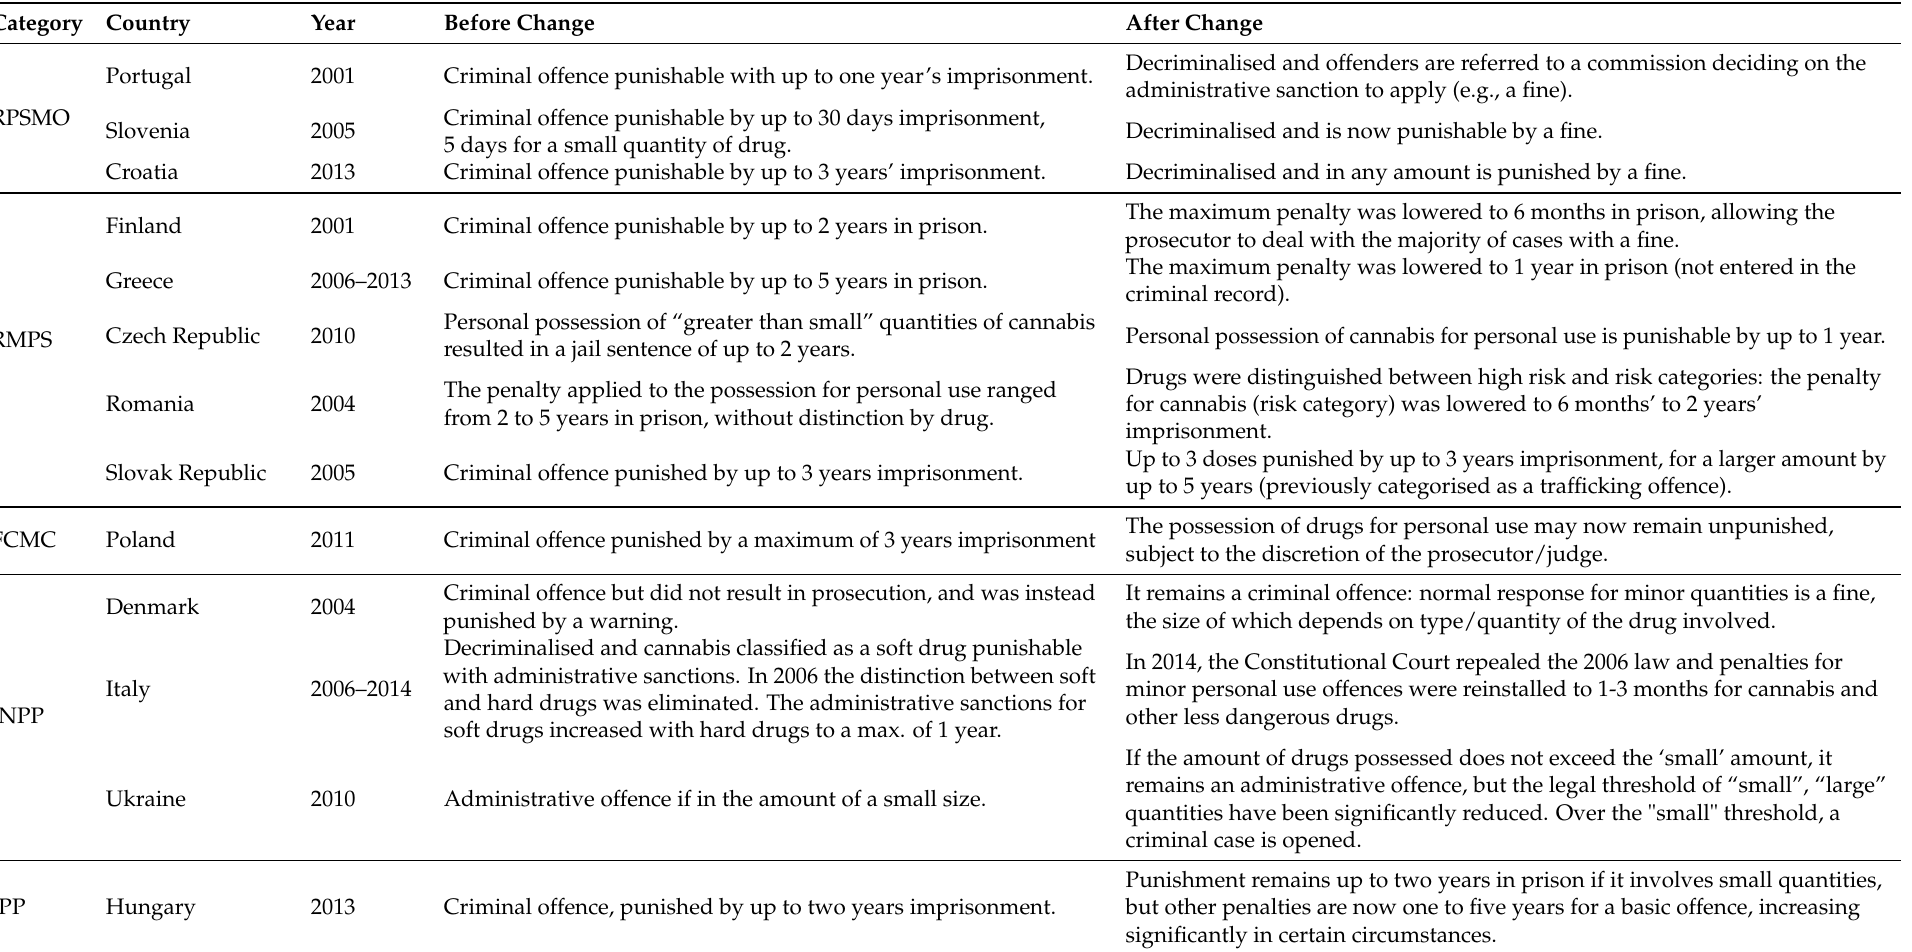
Table 2. Classification of changes in cannabis law regarding possession for personal use occurred in Europe from 2001 to